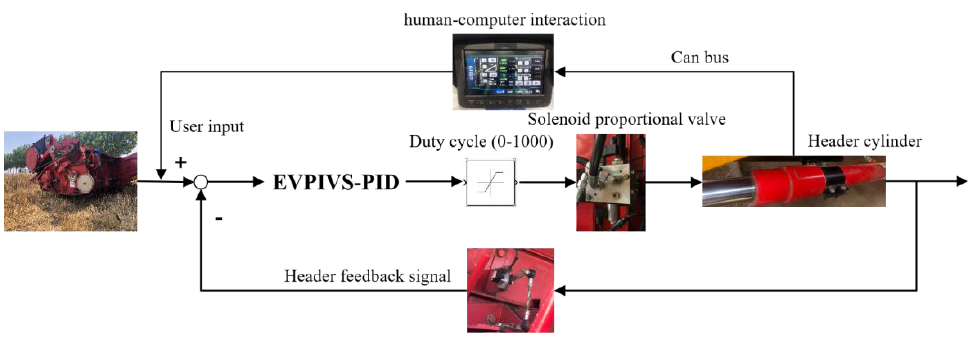
Figure 4. Header adaptive control system structure.